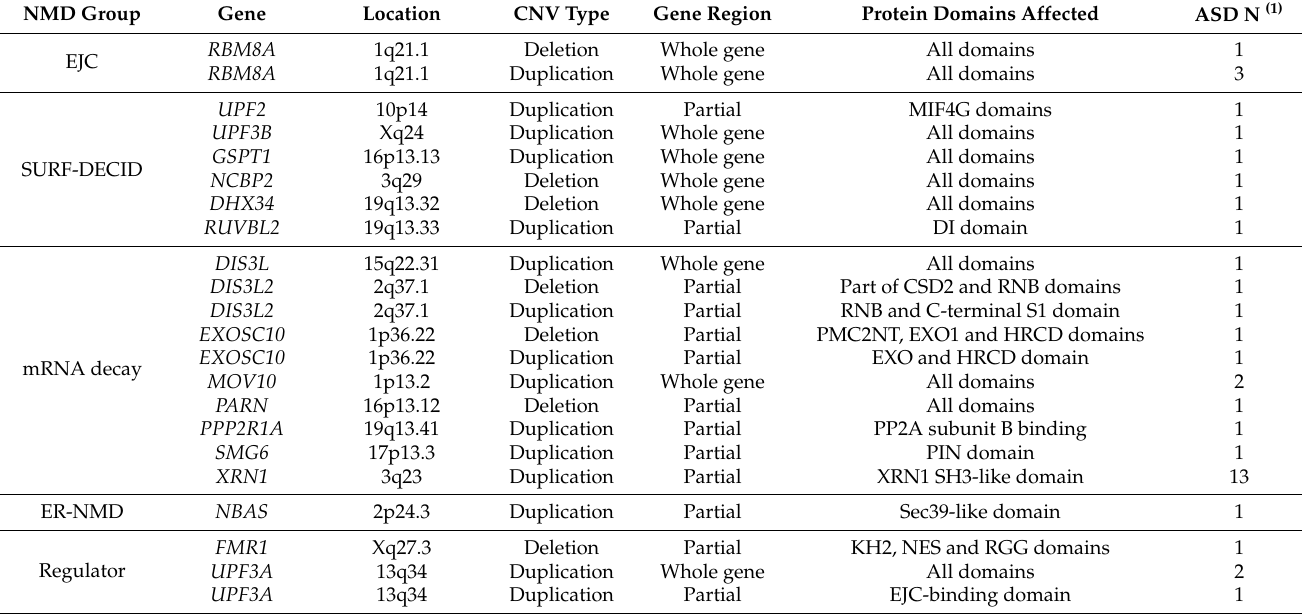
Table 2. NMD genes disrupted by CNVs identified in a population of 3570 ASD patients.